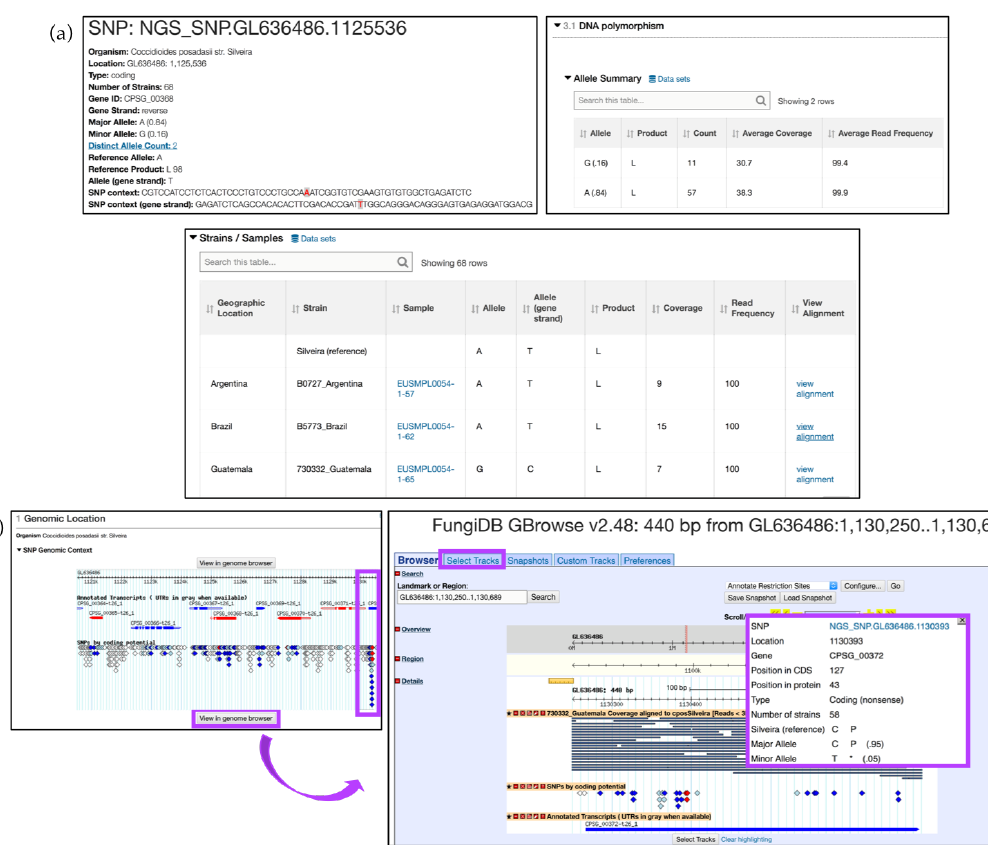
Figure 12. Search for SNPs via the Differences Between Two Groups of Isolates option, continued. ( a ) SNP record for SNP.GL636486.1125536 corresponding to the CPSG_00368 gene. DNA polymorphism and SNP categorization based on Strains/Samples are shown; ( b ) Explore SNPs in FungiDB GBrowse. SNPs are color coded based on their effect on gene function (e.g., nonsense SNPs are shown as red diamonds – highlighted in purple). Click on the View in genome browser button to be re-directed to GBrowse. Individual reads can be activated from the Select Tracks tab (highlighted in purple). Hover over a SNP to activate a pop-up box with additional information (highlighted in purple). Strategy in FungiDB: http://fungidb.org/fungidb/im.do?s=564aa900d161cbbb.